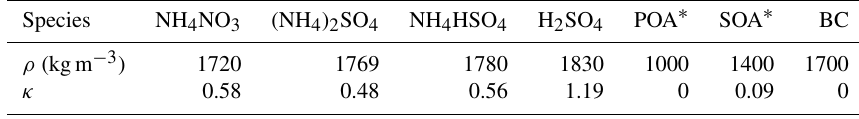
Table 1. Densities of different chemical species and their κ measured by the